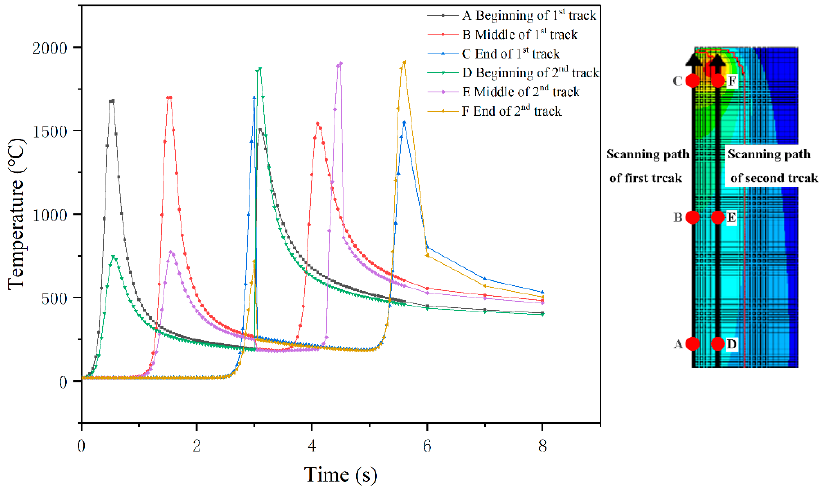
Figure 8. Time-history temperature curves of the multi-track laser cladding process at a laser power of 1500 W and a scanning speed of 0.01 m/s.